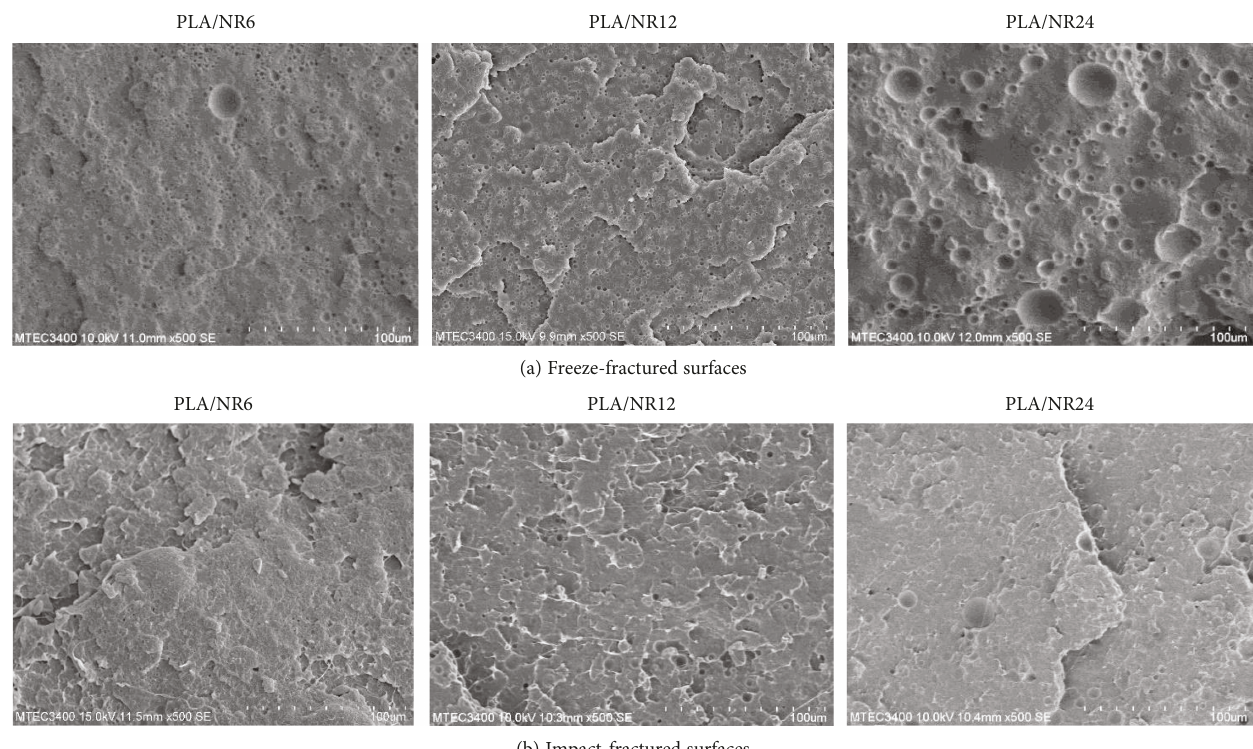
Figure 10: SEM micrographs at 500x of PLA/NR blends using NR masticated for di ff erent mastication